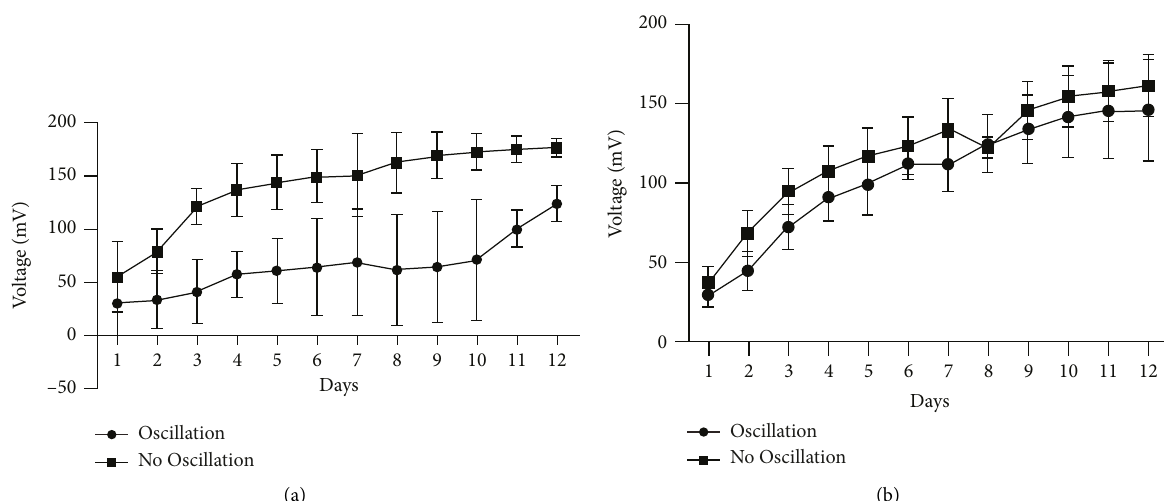
Figure 6: The effect of oscillating vs nonoscillating conditions on MFC voltage (mV ± SD) output by H. salinarum at 37 ° C using either (a) 5cm 2 or (b) 10 cm 2 size platinum carbon cloth electrodes. Nonoscillating conditions significantly ( p < 0 . 0001) affected voltage with a 5cm 2 electrode size, while there was no change ( p � 0 . 3709) with 10cm 2 sized electrodes as per an unpaired T -test with welch correction.